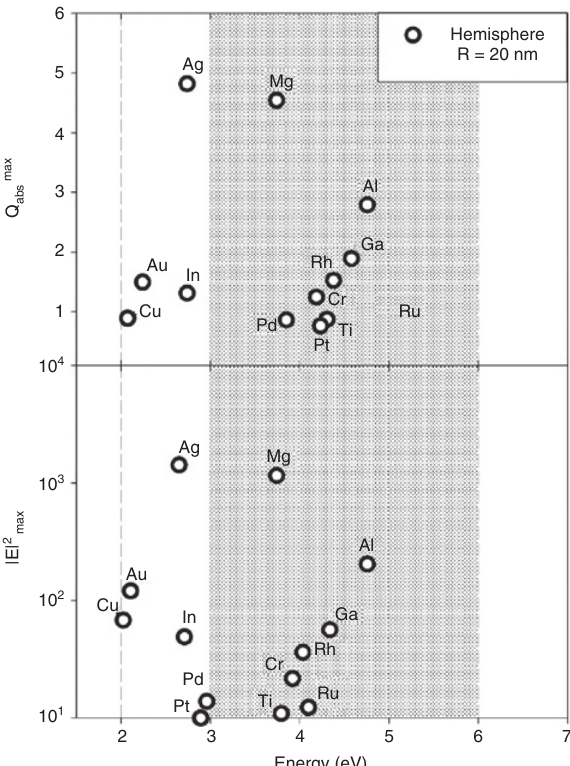
Figure 9: Maximum far-field absorption efficiencies (top) and near- field electric field enhancements caused by the LSPRs in various hemispherical metal nanoparticles of radius R = 20 nm [66]. Reprinted with permission from Ref. [66], copyright 2013, American Chemical